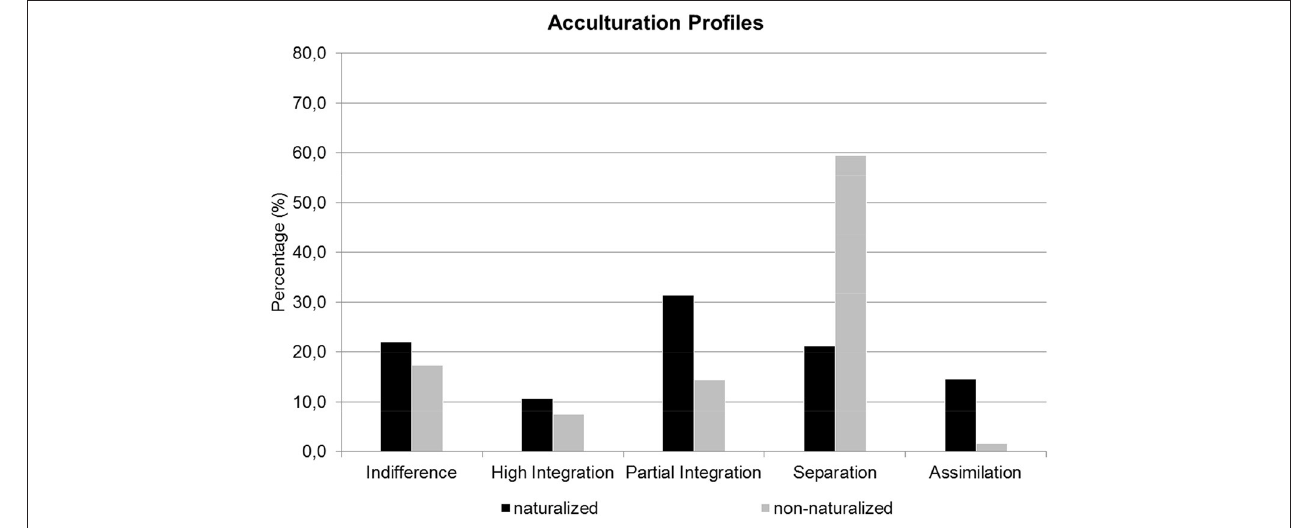
FIGURE 3 | Acculturation profiles of immigrants in Germany.